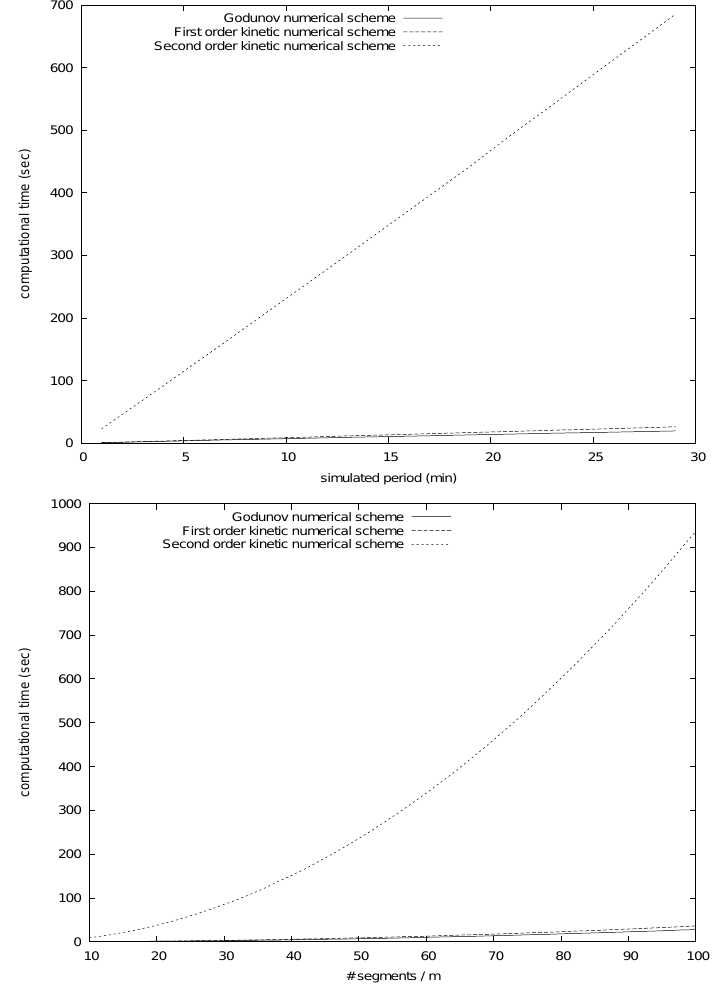
Figure 3. Comparing numerical approximation schemes: computational time (seconds) vs. simulated period (minutes) (top); computational time (seconds) vs. (number